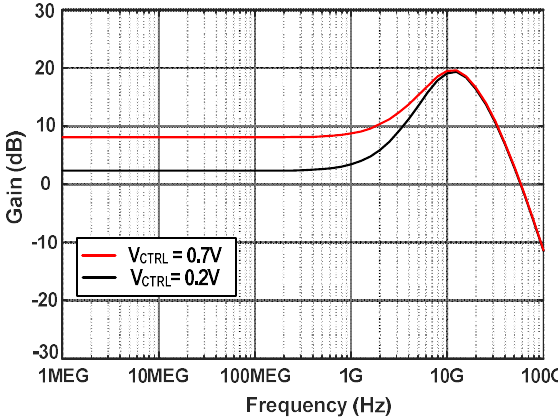
Figure 8. Frequency response of the proposed CTLE for the different V CTRL voltages.